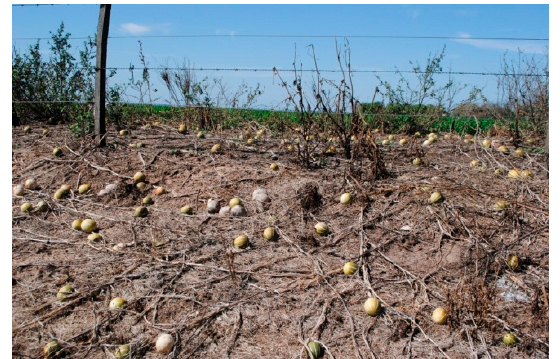
Figure 1. Fruits of C. maxima ssp. andreana in an agriculture field wire fence at Zavalla, Santa Fe province, Argentina. Lack of fruits and seeds’ dispersal is apparent; dry light brown ones are from the previous growing season, yellow ‐ green ones from the current year.